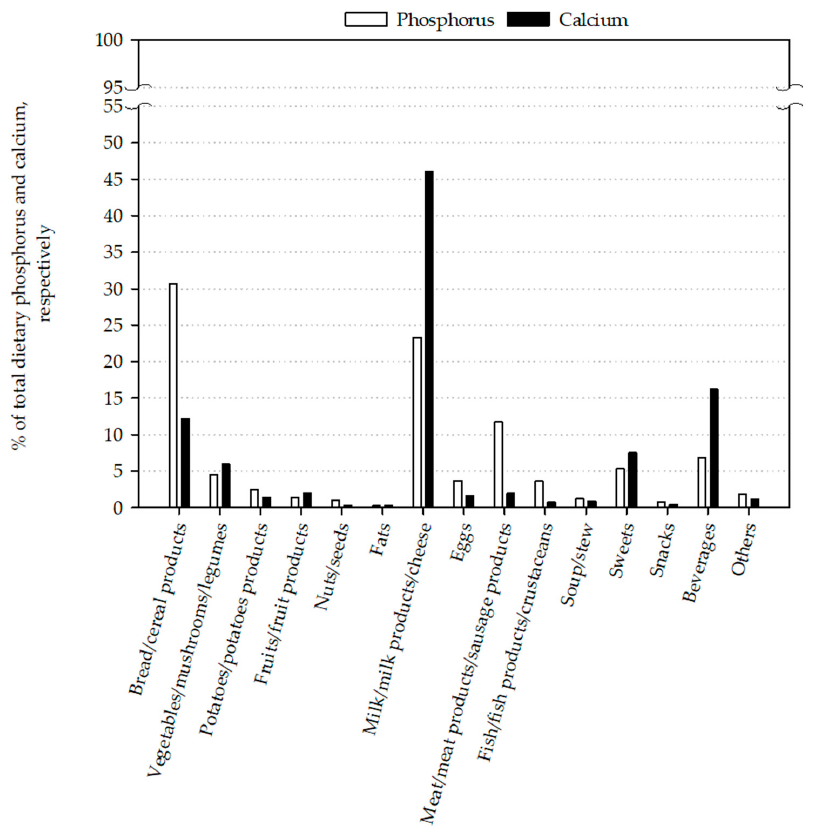
Figure 2. Major food sources for phosphorus and calcium of study 3. Table 5. Contribution of different food product groups to phosphorus and calcium intake.